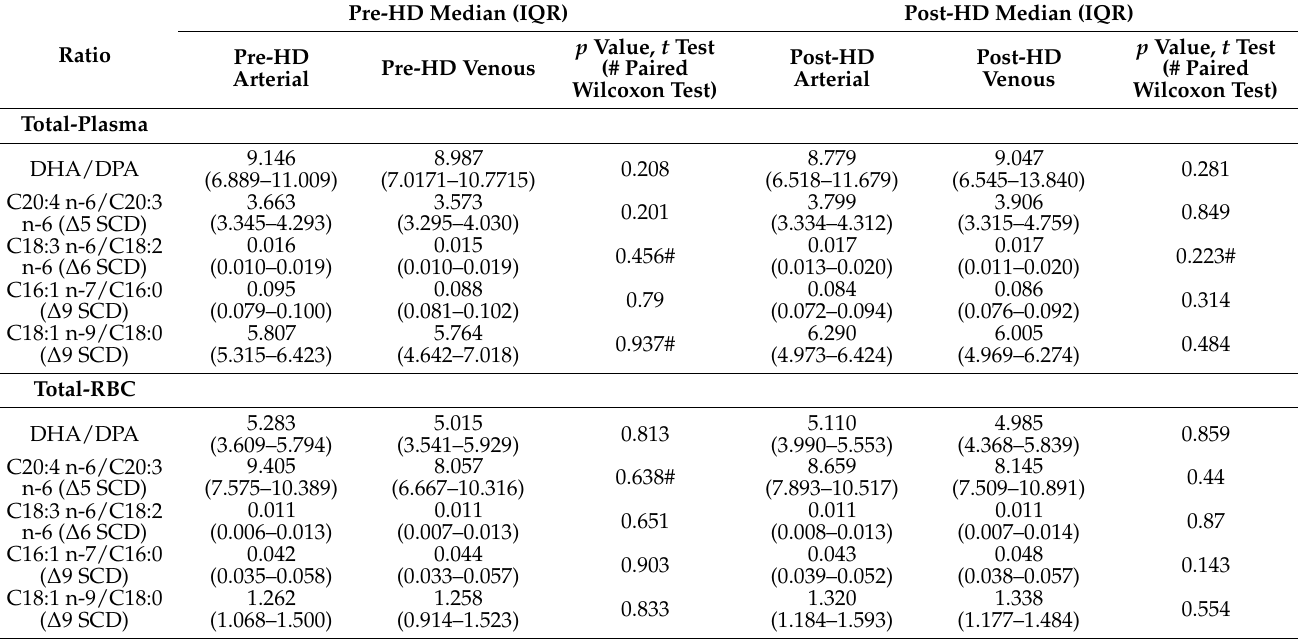
Table 5. Effect of hemodialysis on the ratio of desaturase and peroxisome function in plasma and RBC in the CKD patients before (Pre-HD) and at cessation (Post-HD) of hemodialysis ( n = 12